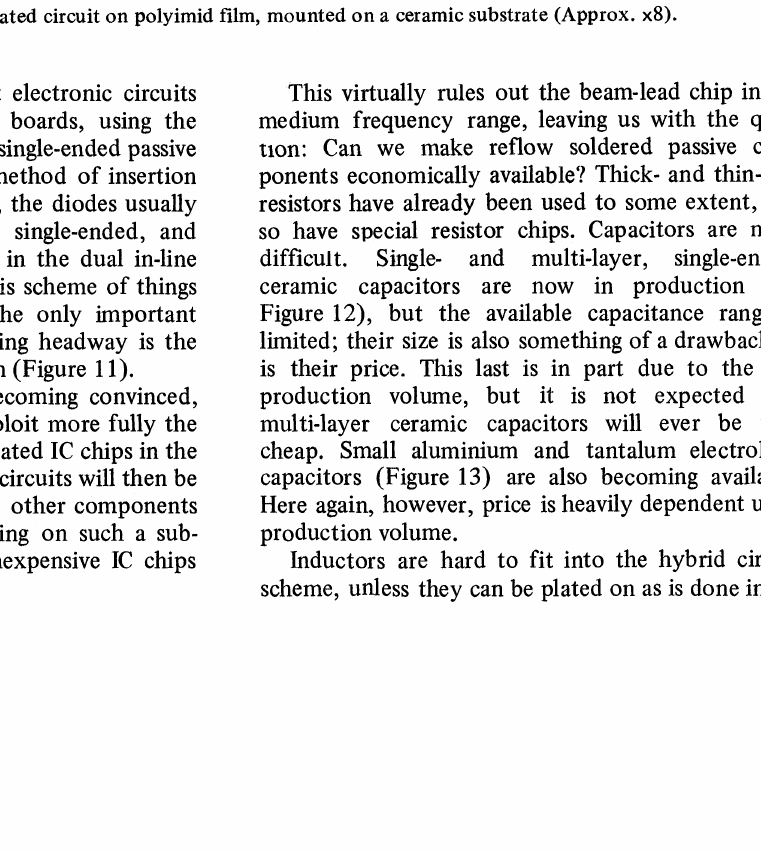
FIGURE 10 Hybrid circuit using SOT 23 encapsulated transistors (Approx. x2).